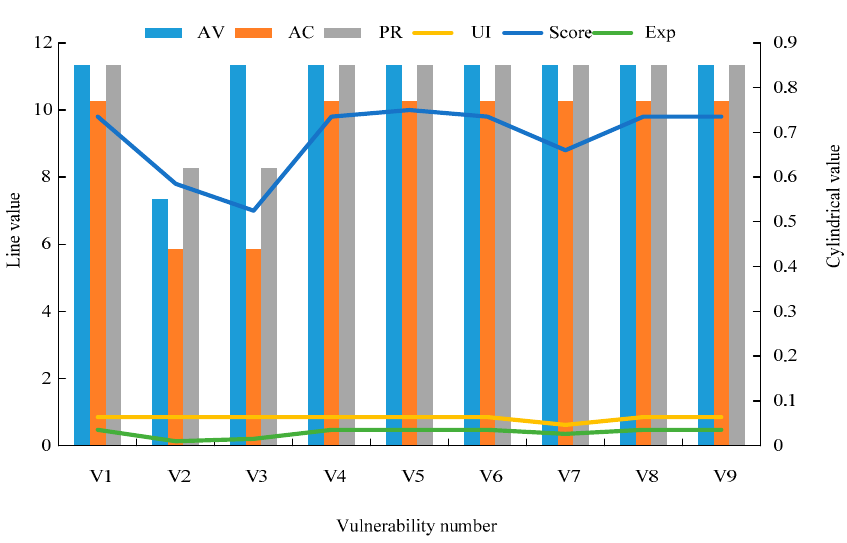
Figure 4. Vulnerability CVSS Score and Availability Information.